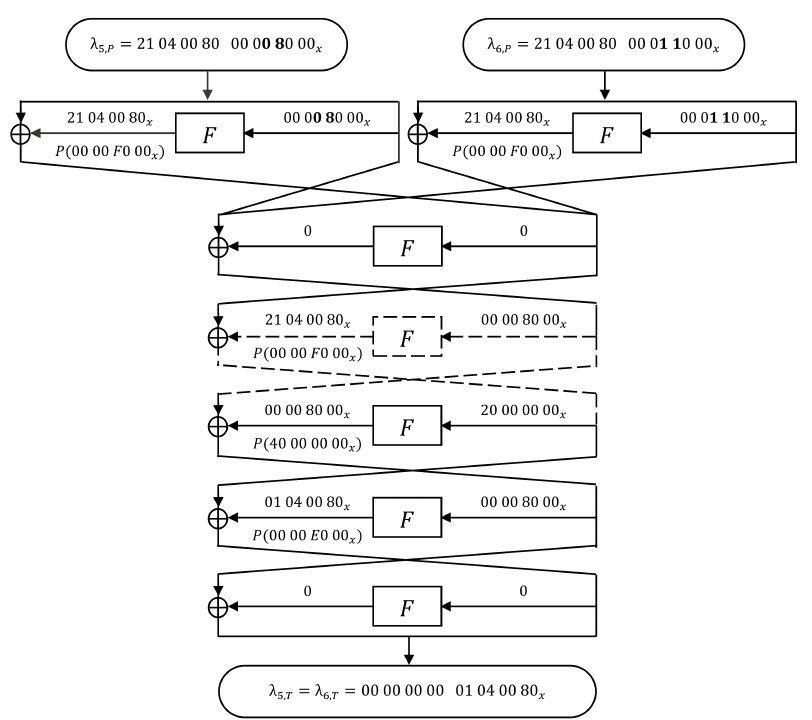
Figure 10: λ 5 and λ 6 . The Figure shows 6 rounds of 14 where the broken lines represent an inclusion of additional 8 rounds of the iterative approximation λ 3 of Figure 8. The first round of λ 5 is demonstrated on the upper left, and the first round of λ 6 is demonstrated on the upper right. The rest of the rounds are the same in both.